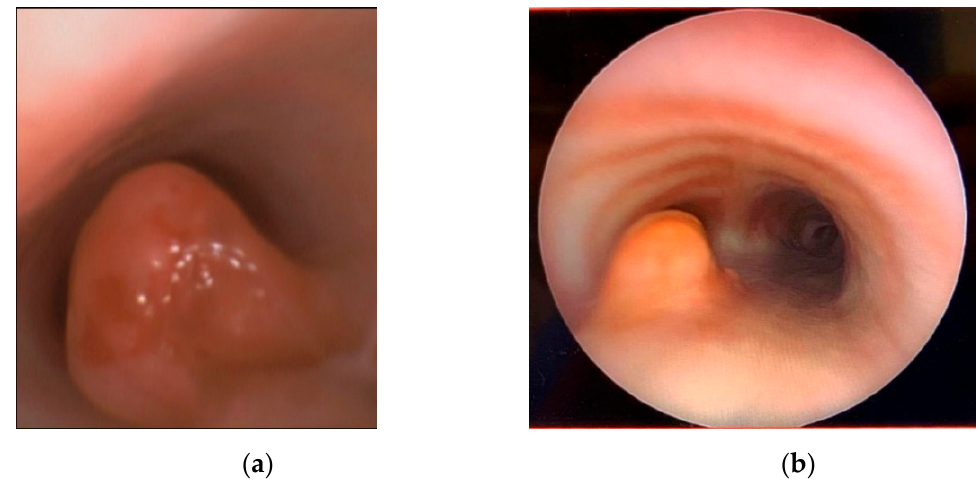
Figure 2. Shown in panels are ( a ) the fibroscopy at diagnosis and ( b ) after 2 weeks of